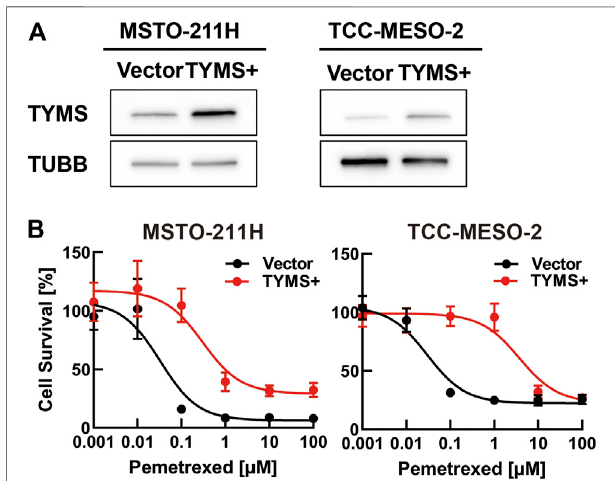
FIGURE 5 | Intracellular metabolite levels in parental and PMX-resistant cells treated with PMX. Intracellular concentration (pmol/10 6 cells) of key metabolites involved in the nucleotide biosynthesis in (A) MSTO-211H vs. MSTO-211H_R and (B) TCC-MESO-2 vs. TCC-MESO-2_R cells after treatmentwithPBSor PMX (1 μ M) for6 h. Errorbars indicate therange ofSD. * p < 0.05, ** p < 0.01, *** p < 0.001 vs. control (PBS) by Welch ’ s